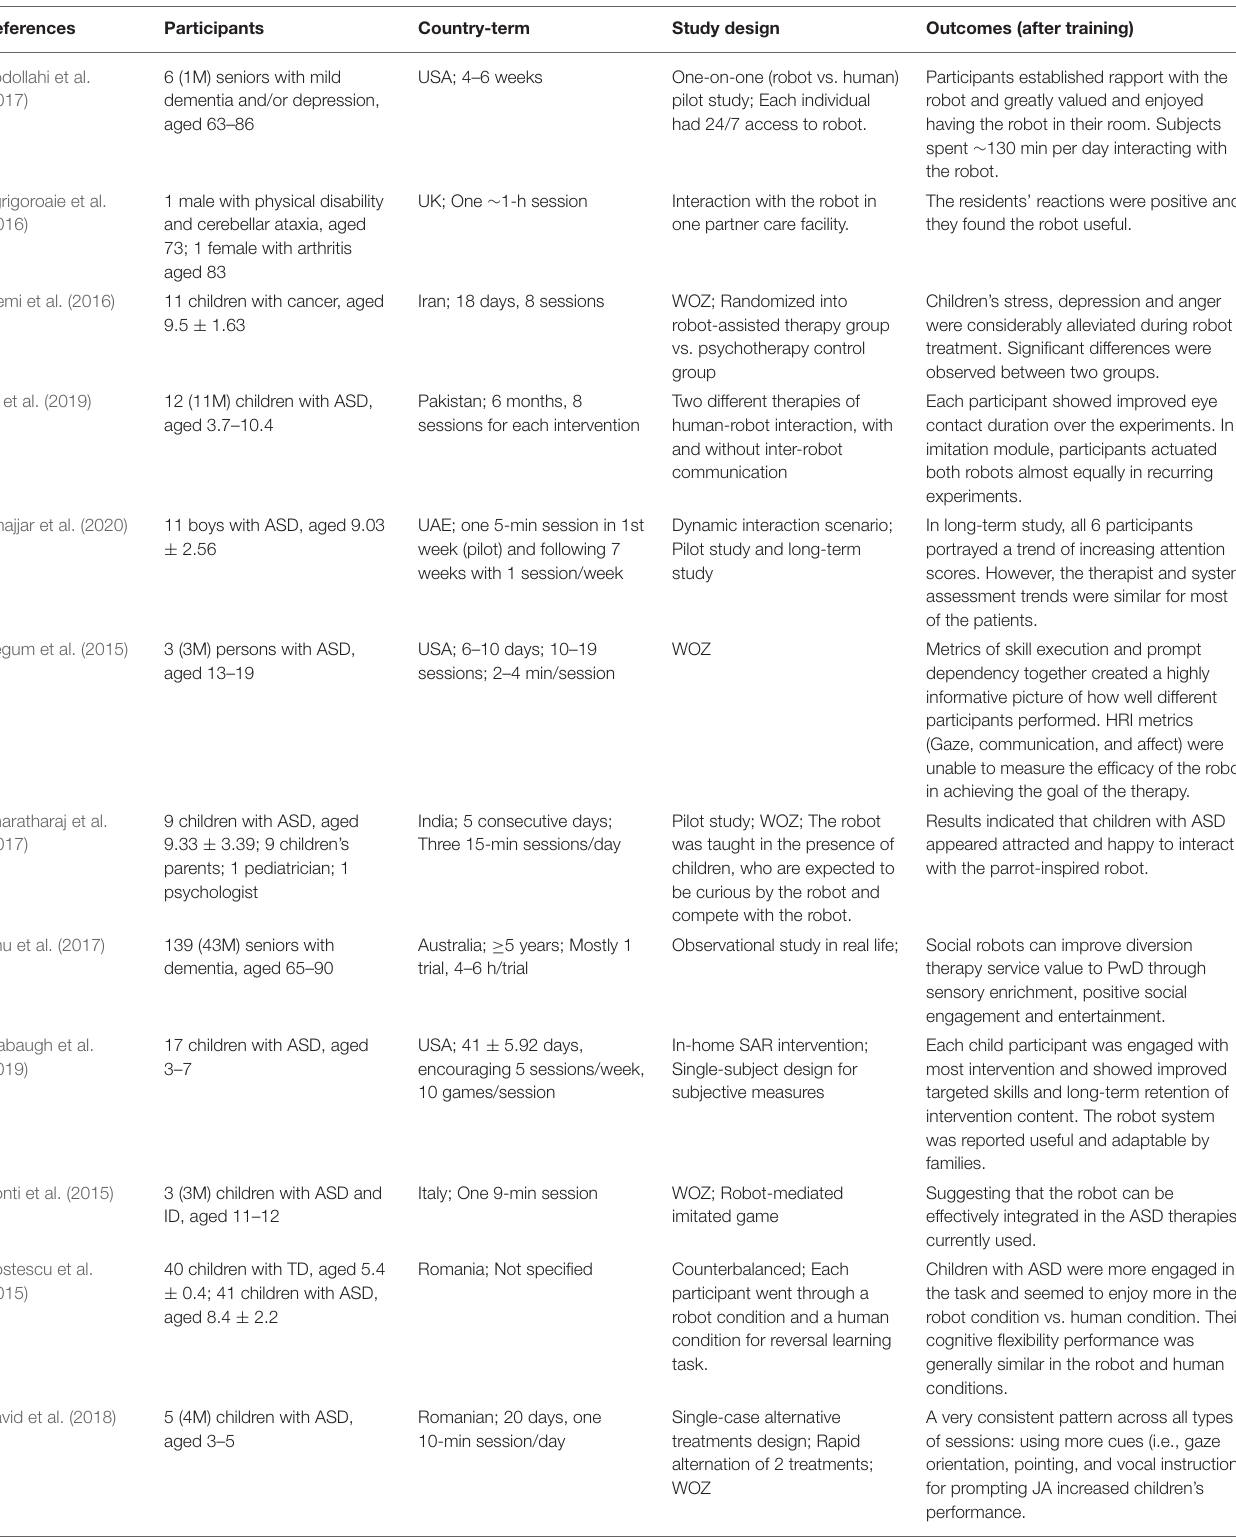
TABLE 2 | Meta analysis on end-user experiments of robot-assisted cognitive